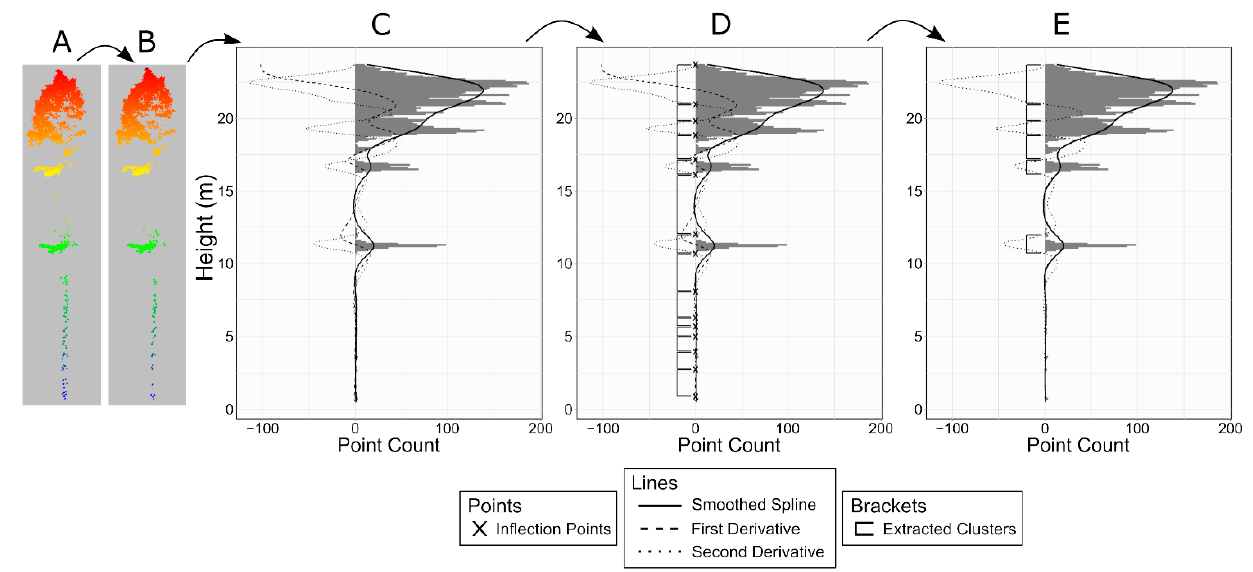
Figure 3. An overview of the live branch cluster extraction method. ( A ) Originally segmented RPAS LiDAR point cloud; ( B ) thinned RPAS LiDAR point cloud; ( C ) histogram, spline, and derivative extractions; ( D ) initial cluster extraction; ( E ) removal of small clusters.